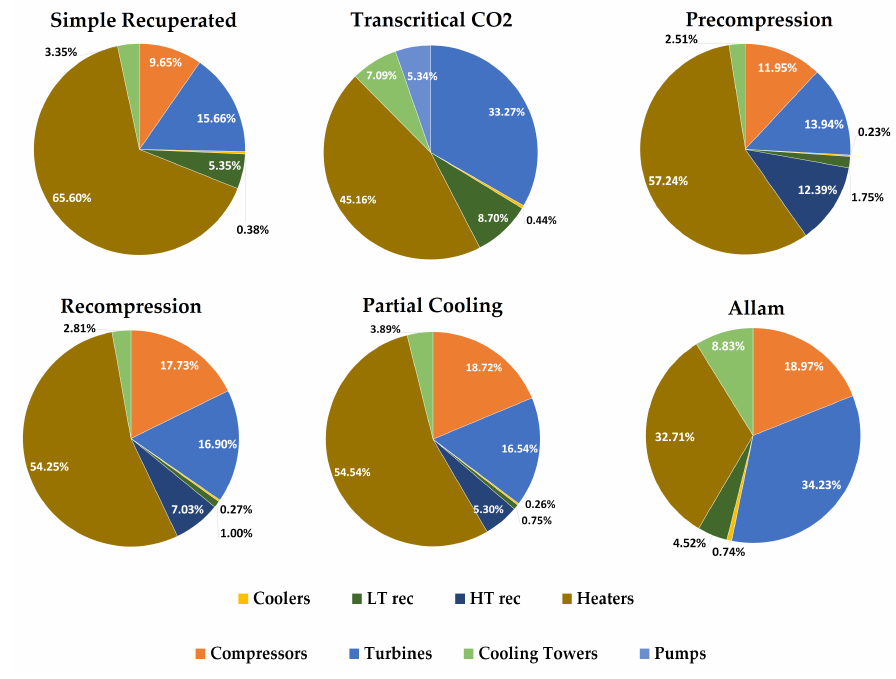
Figure 3. Breakdown of the Overnight Capital Cost of the power block.